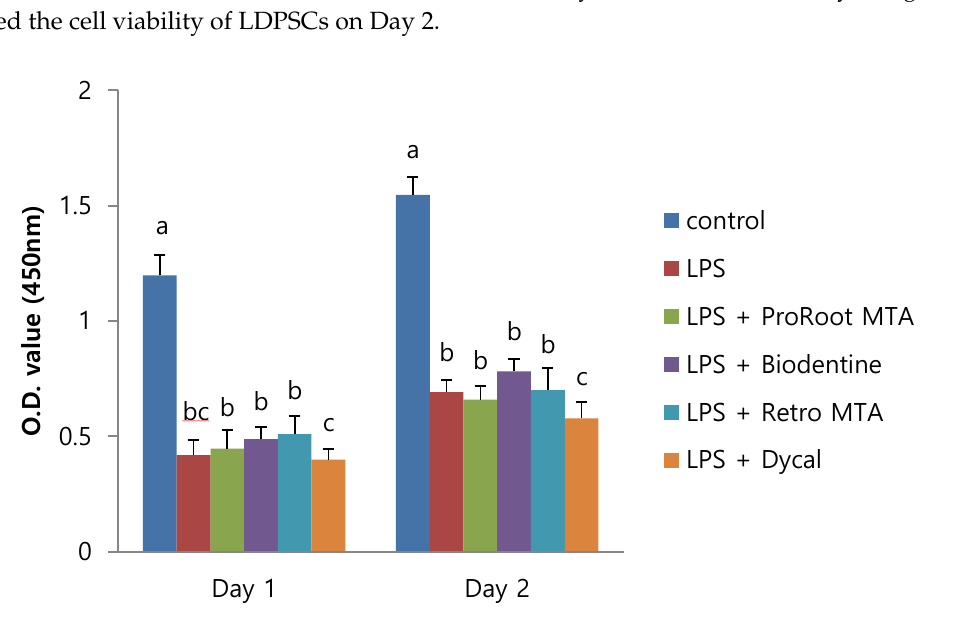
Figure 1. The e ff ects of calcium silicate cements (CSCs) on the cell viability of human dental pulp stem cells (hDPSCs) and LPS-induced dental pulp stem cells (LDPSCs). Absorbance values were measured at 450 nm using the Cell Counting Kit-8 assay. a > b, c; b > c ( p < 0.05), di ff erent alphabet letters represent statistically significant di ff erences between the materials within the same time group. Control, hDPSCs cultured with normal medium; LPS, LDPSCs cultured with normal medium; LPS + ProRoot MTA, LDPSCs cultured with ProRoot MTA extract medium; LPS + Biodentine, LDPSCs cultured with Biodentine extract medium; LPS + Retro MTA, LDPSCs cultured with Retro MTA extract medium; LPS + Dycal, LDPSCs cultured with Dycal extract medium. O.D., optical